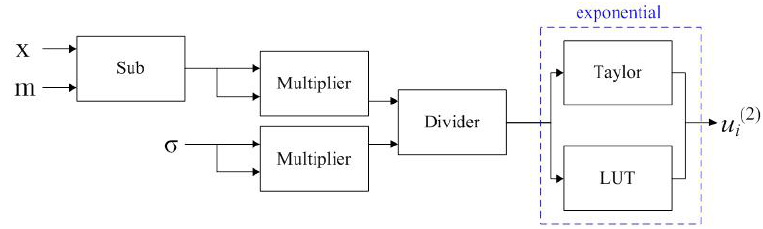
Figure 9. Block diagram of Gaussian function with Taylor expansion and LUT.